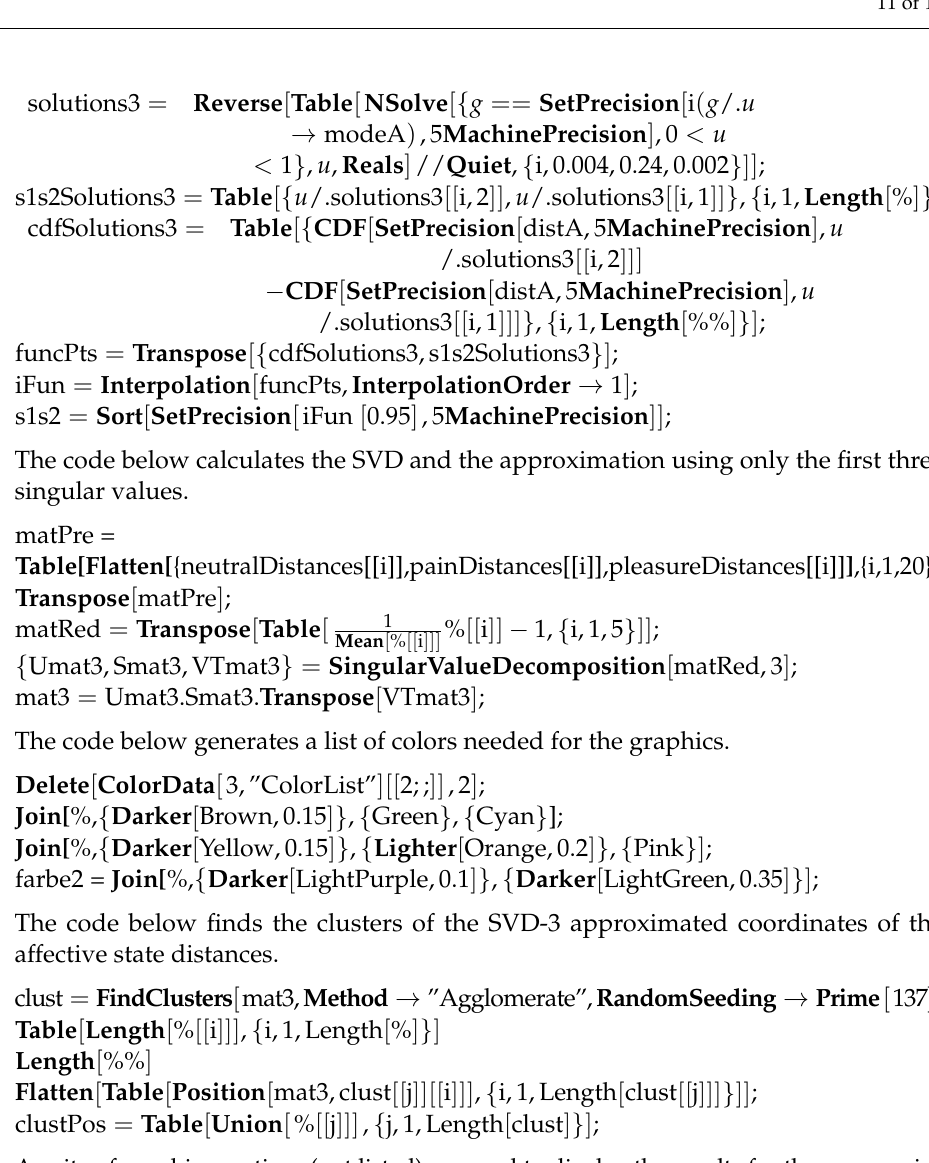
solutions3 = Reverse [ Table [ NSolve [ { g == SetPrecision [ i ( g /. u → modeA ) , 5 MachinePrecision ] , 0 < u